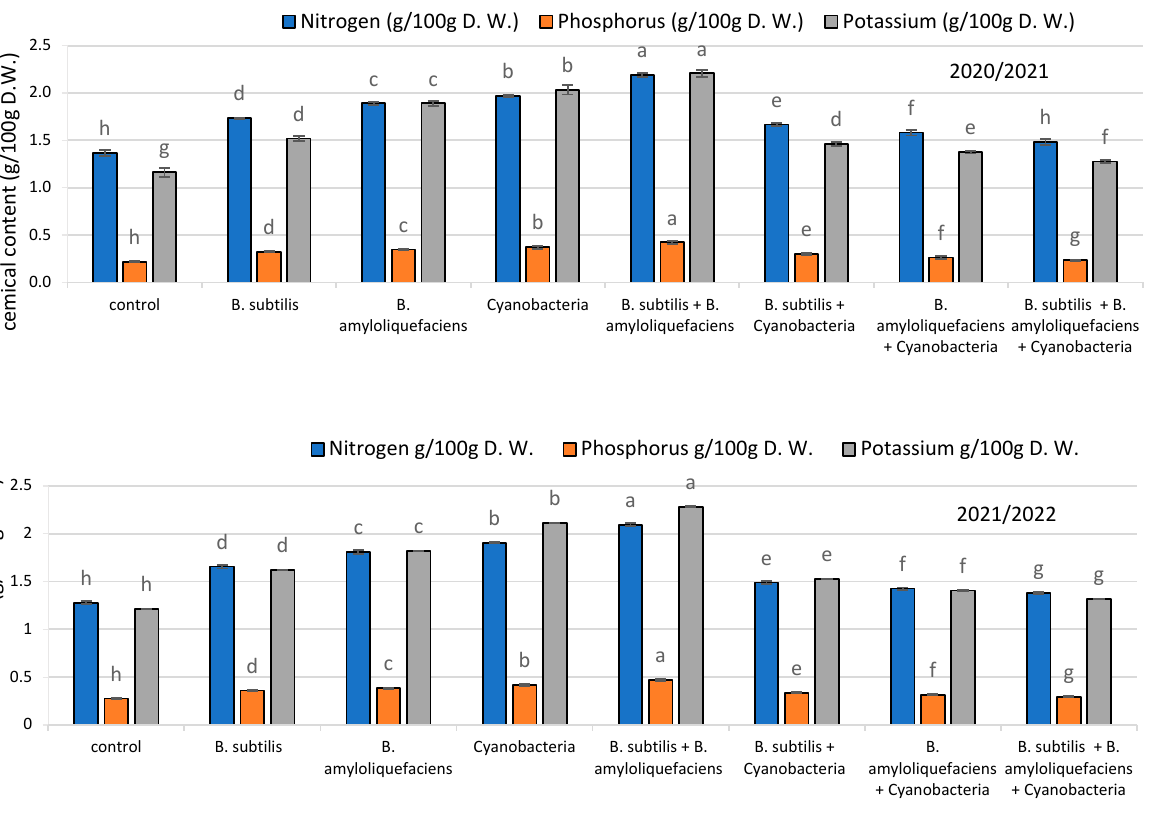
Figure 6. The effect of inoculation with two PGPR strains ( B. subtilis and B. amyloliquefaciens ) and cyanobacteria on the chemical content (Nitrogen, phosphorus and potassium) (g/100g D.w.) of tomato fruits in two seasons (2020/2021) and (2021/2022). Different letters indicate significant differences between treatments (ANOVA, LSD, p < 0.05). Error bars represent standard error of the mean.